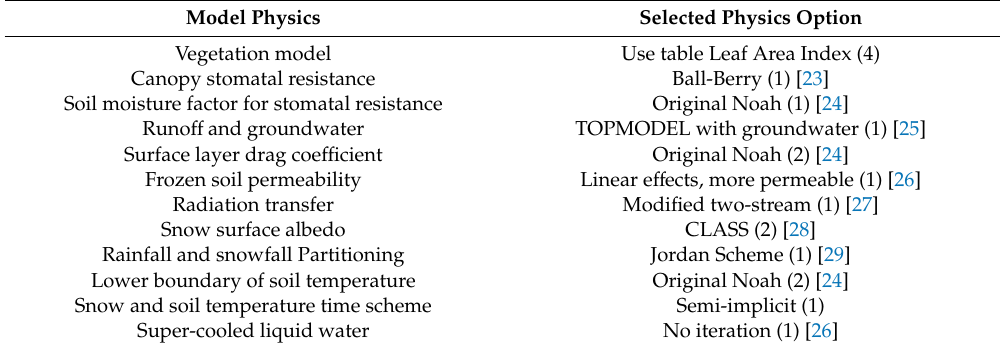
Table 1. Noah-MP (multi-parameterization) model physics options.